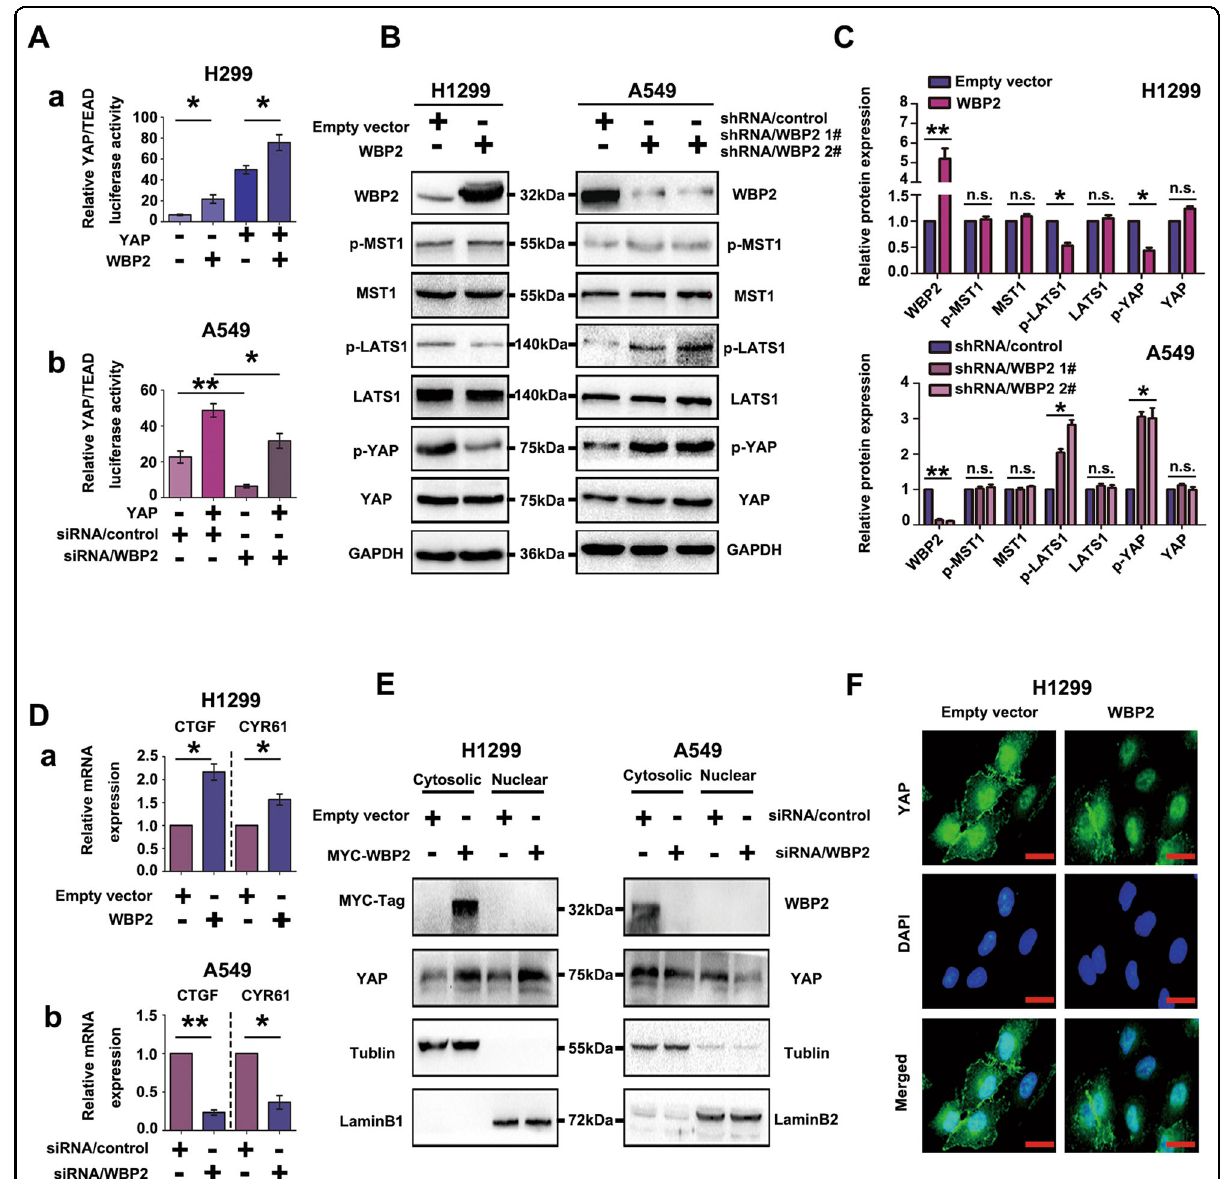
Fig. 4 WBP2 is a negative regulator of the Hippo pathway in lung cancer cells. A ( a , b ) WBP2 upregulates the transcriptional activity of the TEAD promoter. The WBP2 plasmid and siRNA-WBP2 were transfected into H1299 and A549 cell lines, respectively. After 48 h, the cells were collected and lysed. Dual-luciferase reporter gene detection shows that the ectopic expression of WBP2 can signi fi cantly upregulate the transcriptional activity of TEAD ( A – a ), whereas it decreases after WBP2 knockdown ( A – b ). Transfection with YAP was used as the stimulus. TK was used as the internal reference. B , C WBP2 downregulates LATS1 phosphorylation and YAP phosphorylation through an MST-independent pathway. After overexpression and knockdown of WBP2 in H1299 and A549 cells, respectively, the phosphorylation and total amount of key proteins in the Hippo pathway were analyzed by western blotting. GAPDH was used as the loading control. Differences were analyzed using the Image J software. * P < 0.05, ** P < 0.01. D ( a , b ), RT-qPCR analysis reveals that the mRNA levels of CTGF and CYR61 are upregulated after WBP2 overexpression in H1299 ( D – a ), and the mRNA levels of these two target genes are downregulated ( D – b ) after WBP2 silencing in A549 cells. P < 0.05 indicates statistical signi fi cance, * P < 0.05, ** P < 0.01. E Nuclear and cytosolic fractionation assays indicate that WBP2 overexpression promotes YAP nuclear translocation in H1299 cells, whereas WBP2 silencing in A549 exerts the opposite effect. Beta-tubulin and LaminB1 were used as the cytosolic and nuclear loading controls, respectively. F Immuno fl uorescence assay results reveal that the level of YAP nuclear translocation increases in response to WBP2 overexpression in H1299 cells. Magni fi cation: ×400, scale bar: 50 μ m.